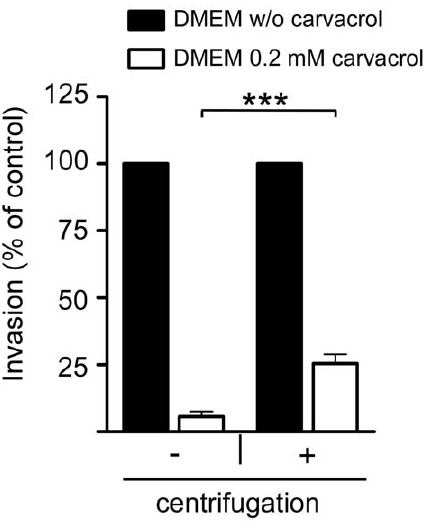
Figure 6. Partial restoration of invasion in carvacrol-treated C. jejuni . Invasion of C. jejuni (strain 108) into INT-407 cells was determined in the absence (filled bars) and presence (open bars) of 0.2 mM of carvacrol, without ( 2 ) and with ( + ) centrifugation of the bacteria onto the cells at the start of the infection. Note the five-fold increase in invasion by C. jejuni grown with carvacrol after centrifuga- tion. Results are expressed as percentage of invasion in the absence of carvacrol and are mean values 6 standard error of at least three independent experiments. *** p # 0.001.